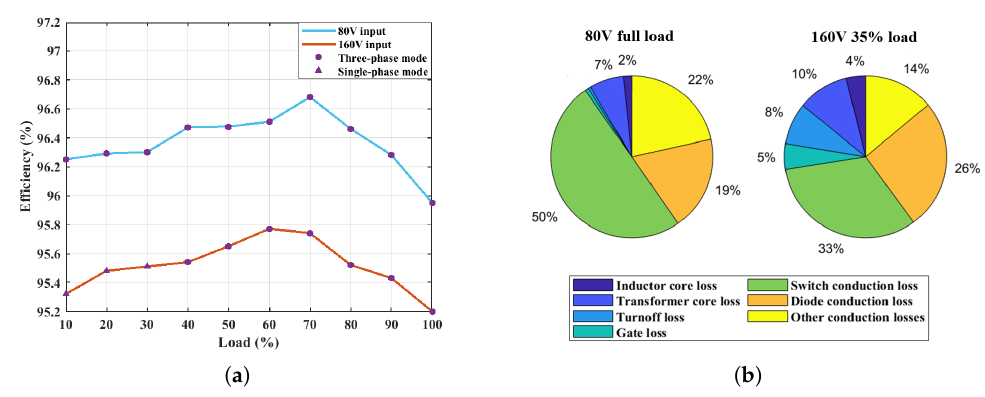
Figure 21. ( a ) Efficiency curve ( b ) Power loss